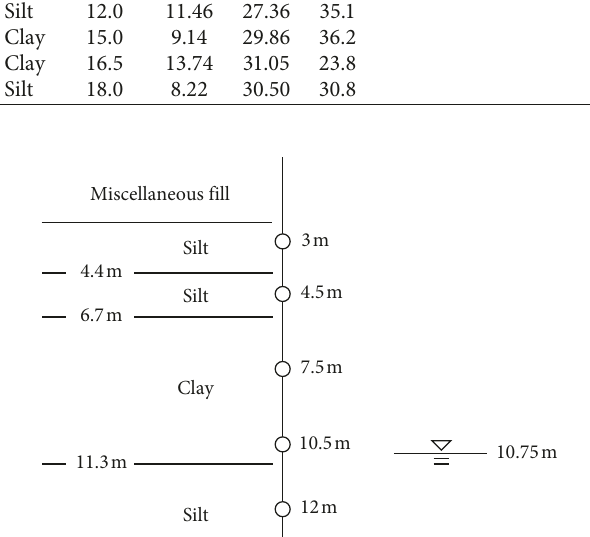
Figure 3: Layout of monitor points. z monitor points; D: settlement monitor point.